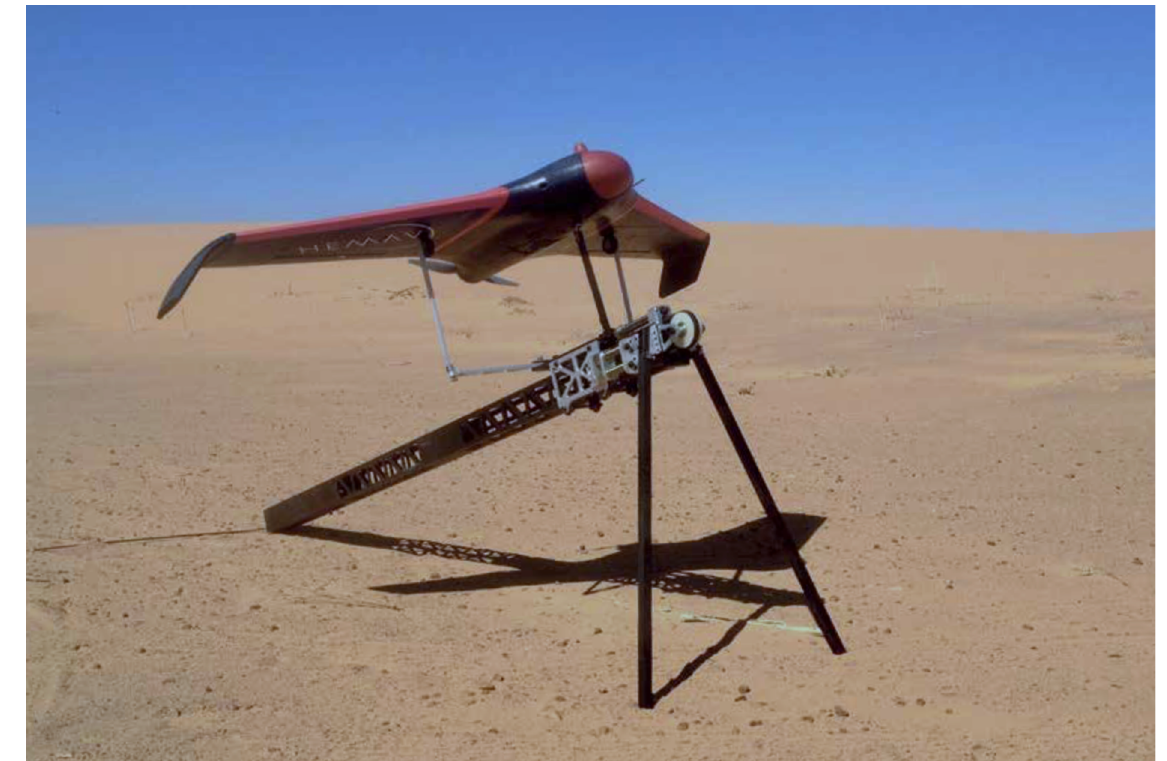
Figure 2. Fixed wing drone for desert locust monitoring (source: FAO [24]).